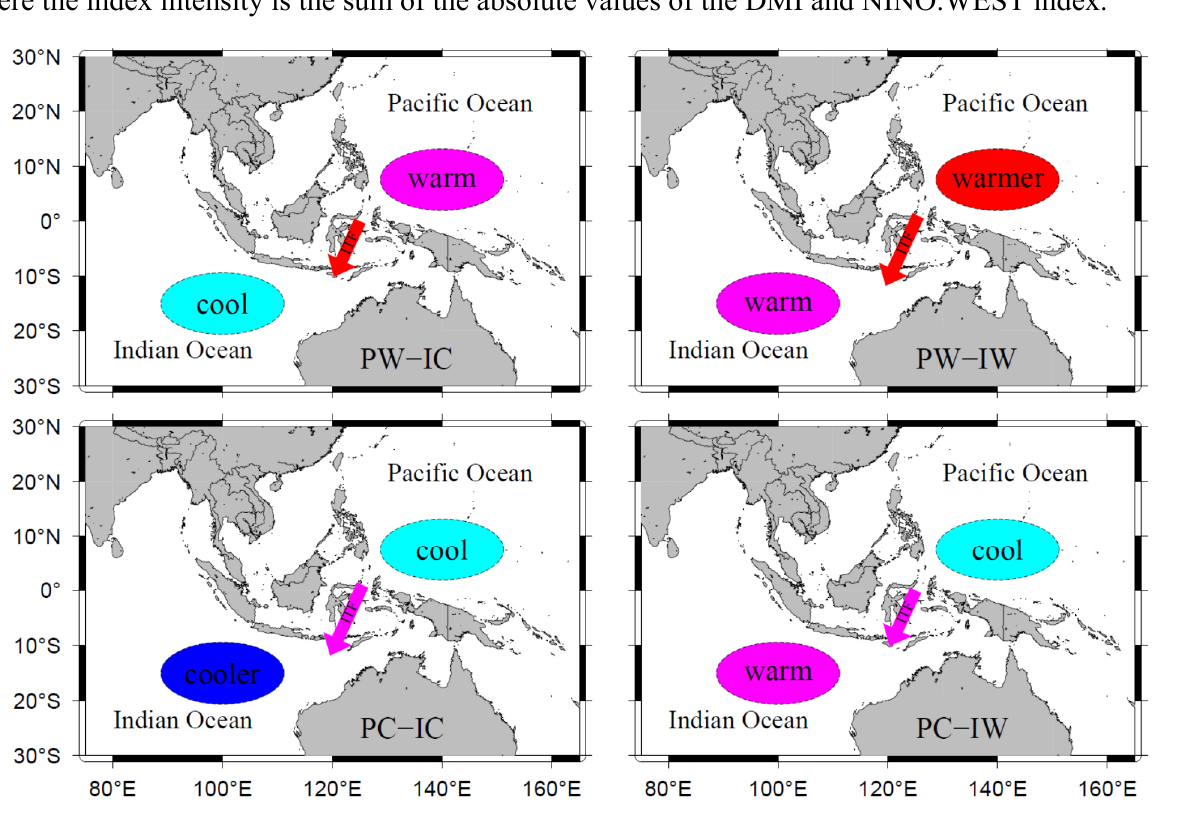
Figure 3. Four synoptic scenarios for the ITF conditions based on sea level anomaly and the associated hydraulic head difference between the Pacific Ocean and the Indian Ocean with respect to the relative SSTs. The length of the arrows represents the ITF residence time. Note that the ITF always flows from the Pacific Ocean to the Indian